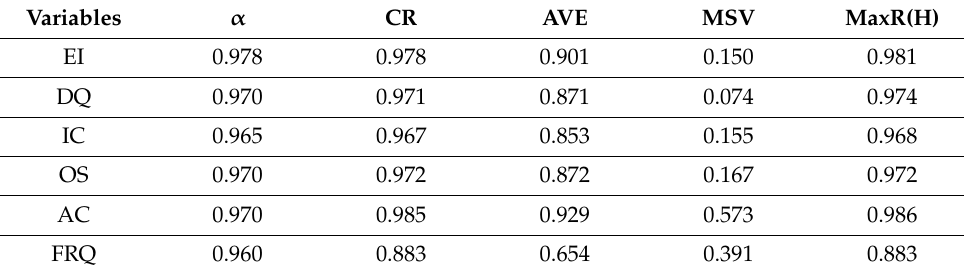
Table 3. Convergent validity for the overall measurement model.